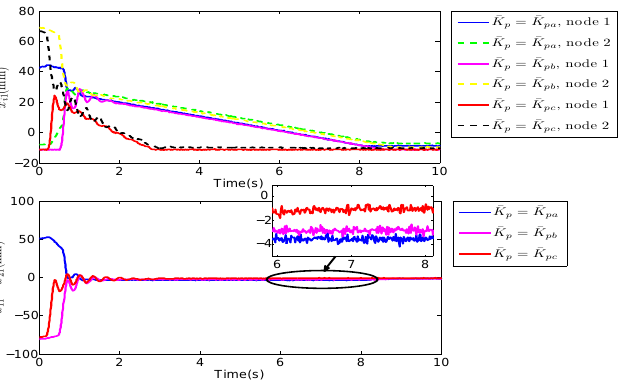
Figure 12. The compared position response results of the three state-feedback matrices using pole placement in the experiment.